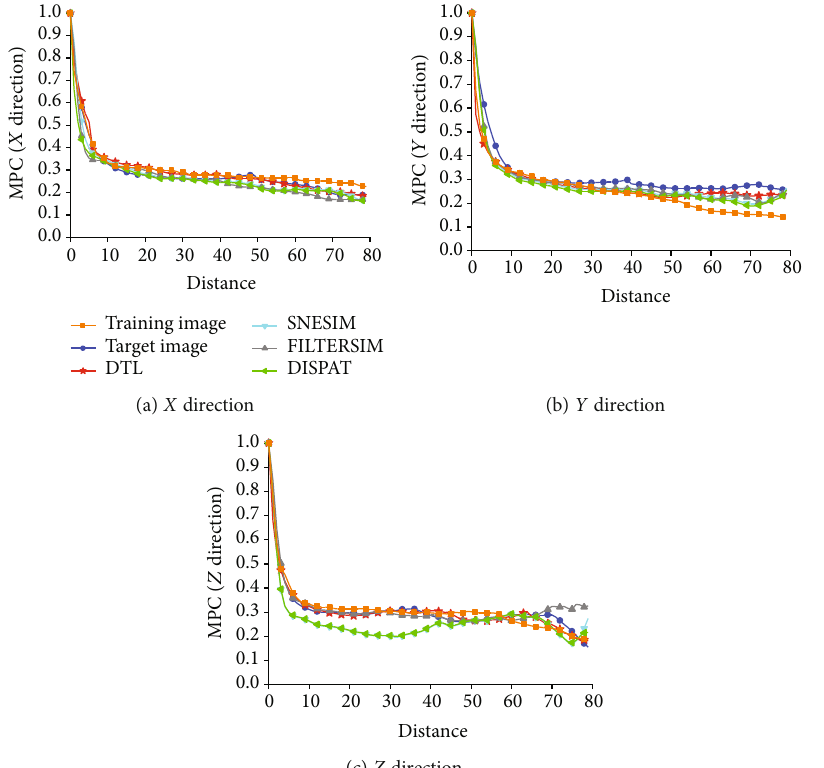
Figure 20: MPC curves (shale) of the TI, the target image, and reconstructed images using SNESIM, FILTERSIM, DISPAT, and DTL.